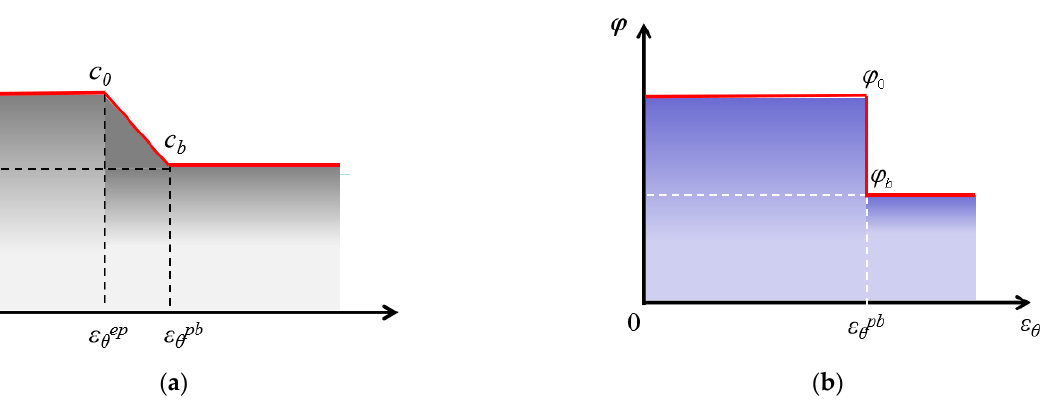
Figure 3. Strain-softening model of tunnel surrounding rock. ( a ) Cohesion strain-softening model; ( b ) Internal friction angle strain-softening model.